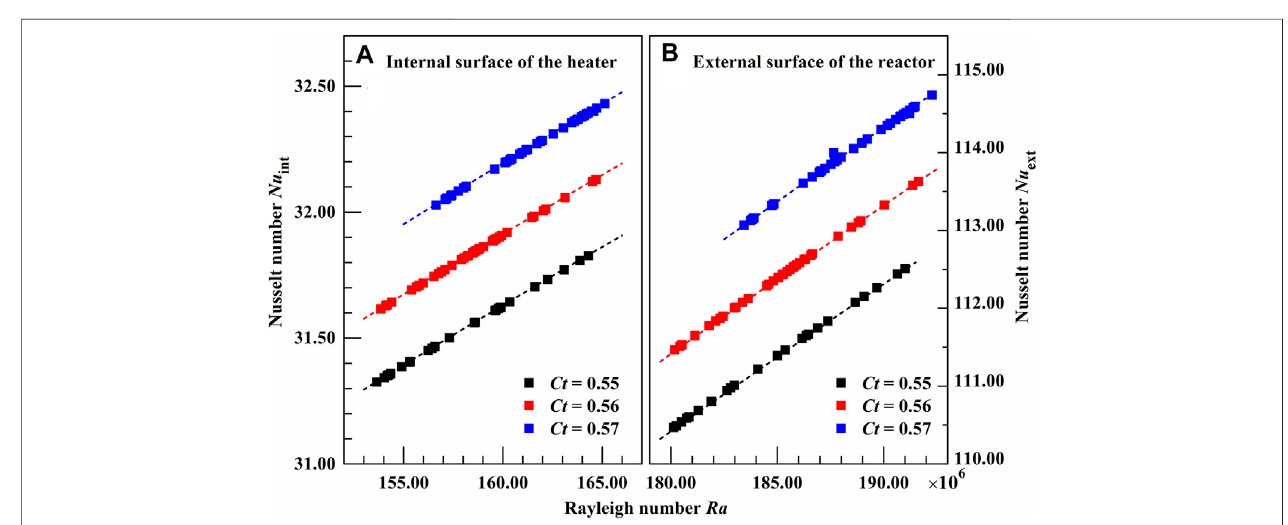
FIGURE 3 | Relationship between Nusselt number and relative dimensionless parameters of the natural convection.